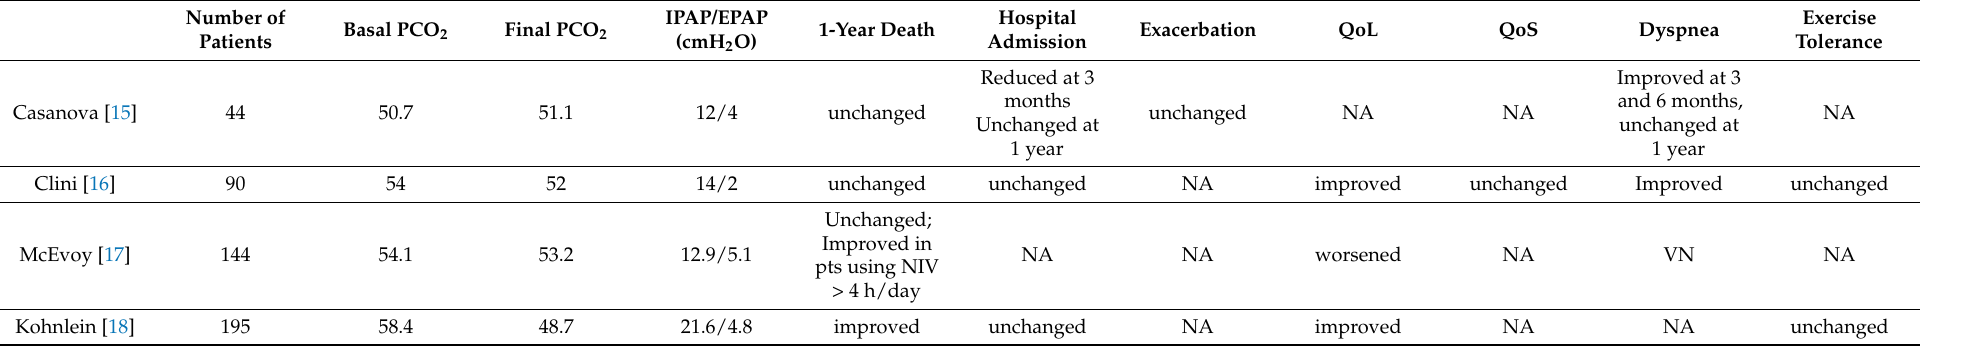
Table 1. Shows a summary of the characteristics and main results of the RCTs about the effect of HNIV on stable hypercapnic respiratory failure. Number of